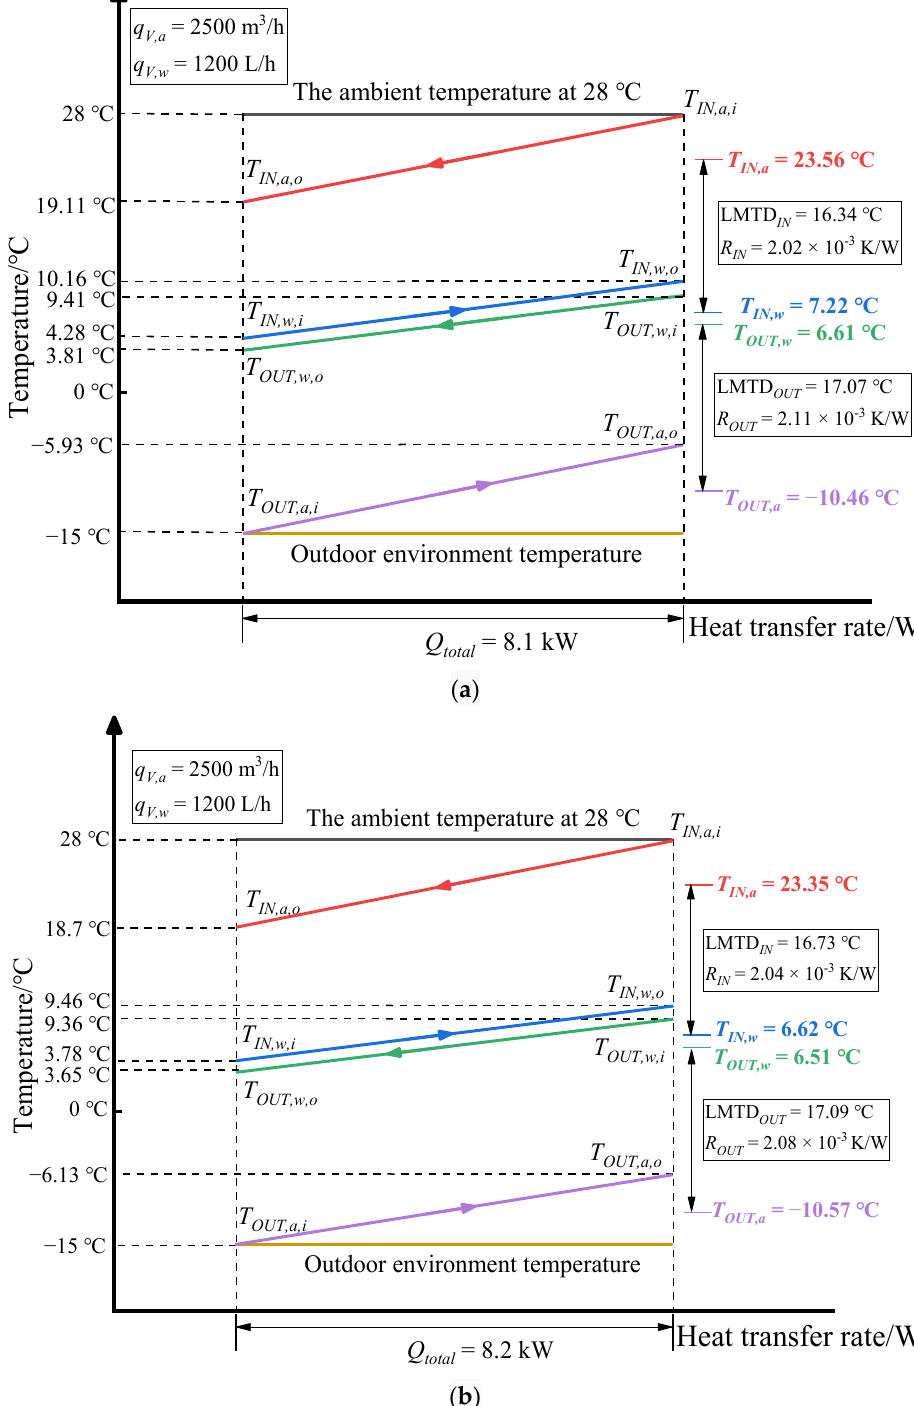
Figure 12. Distribution diagram: ( a ) SNCS at N = 0.75; ( b ) SNCS at N = 0.6. According to the above optimization analysis of SNCS at different N , the combination form of SNCS at N = 0.75 was more reasonable and had a better heat transfer performance with the balanced temperature and thermal resistance distribution.